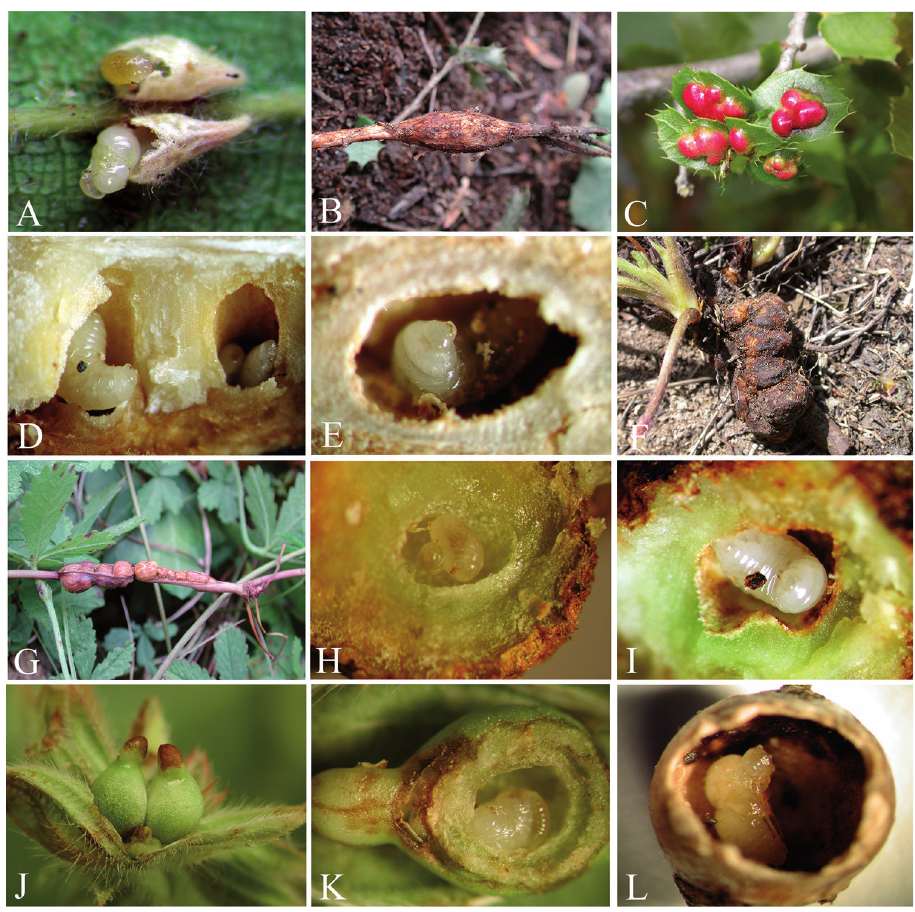
Figure 15. A larvae of O. pomaceus and Trigonaspis brunneicornis within gall cells B gall of Plagiotrochus razeti (asexual) on Quercus C galls of Plagiotrochus quercusilicis on Quercus D larvae of Ormyrus pomaceus within cells of galls of P. razeti E detail of larva of Ormyrus pomaceus within cell of gall of P. razeti F galls of Xestophanes potentillae on subterranean rhizome of Potentilla reptans G galls of X. potentillae on air runners of P. reptans H larvae of O. rufimanus on larvae of X. potentillae within gall cell I larvae of O ru- fimanus with debris of dead host within gall cells of X. potentillae . J galls of Neaylax verbenacus on Salvia verbenaca K larvae of O. wachtli on larvae of N. verbenacus within gall cell L pupae of O. wachtli within gall of Neaylax salviae